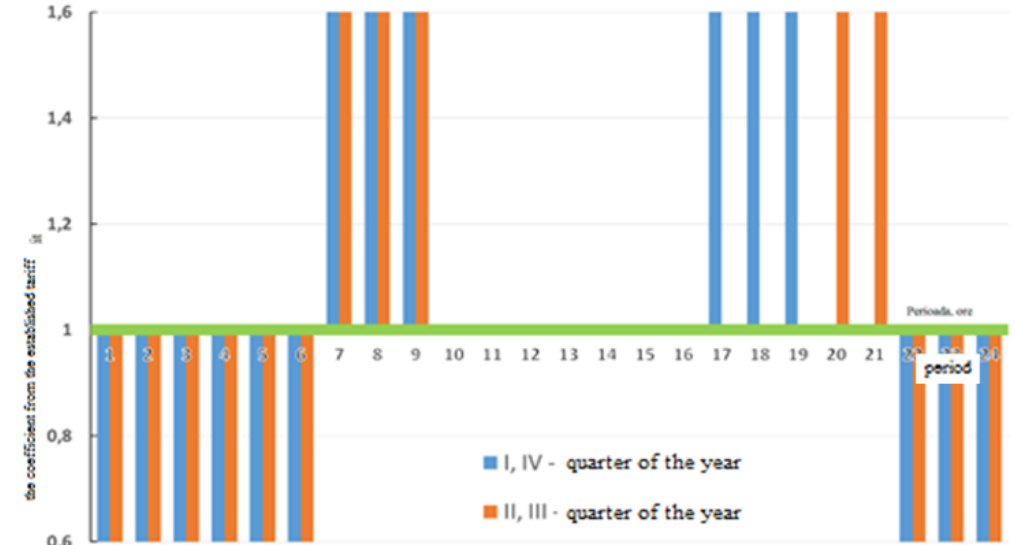
Figure 14. Cost of electricity according to differentiated rates depending on the consumption